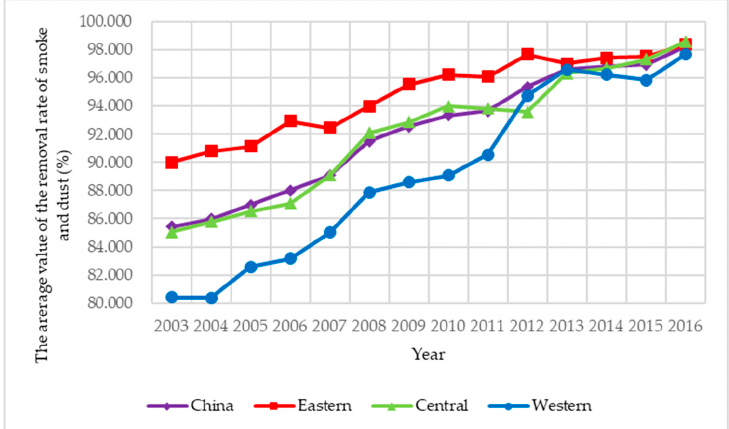
Figure 6. The average value of the removal rate of smoke and dust in China during 2003–2016.